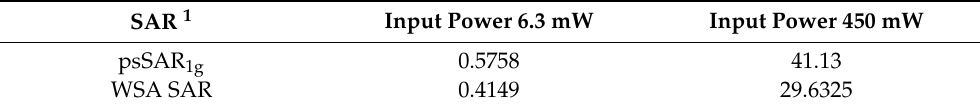
Table 3. Peak 1 g spatial-average SAR and SAR averaged over the entire mass of the cell suspension produced in the numerical model of erythrocyte suspension at two input powers of the wearable antenna, at 2.41 GHz. SAR 1 Input Power 6.3 mW psSAR 1g WSA SAR